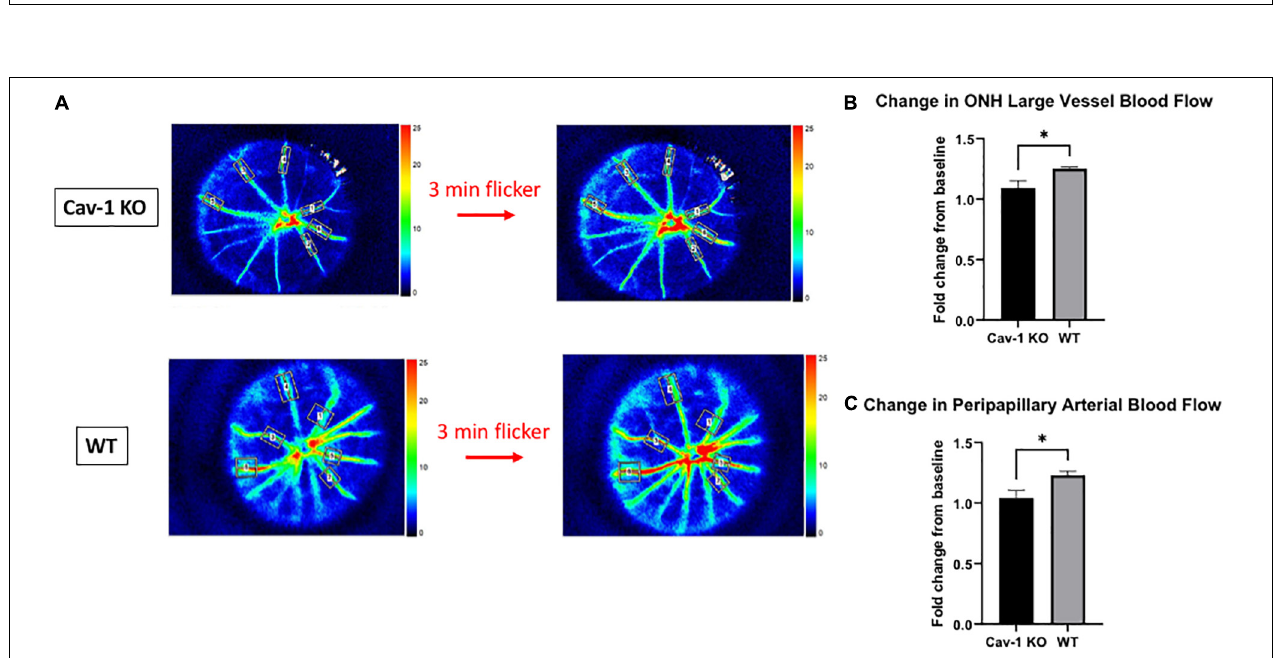
FIGURE 2 | Blood flow changes after 3 min of light flicker stimulus indicates differences in the neurovascular coupling of response of Cav-1 KO compared to WT mice. (A) Representative LSFG images taken at the optic nerve head in Cav-1 KO and WT mice. (B) Cav-1 KO show a lesser increase in large vessel blood flow at the optic nerve head after flicker stimulus, compared to WT. (C) Cav-1 KO show a lesser increase in peripapillary arterial blood flow after flicker stimulus, compared to WT, * p < 0.05.